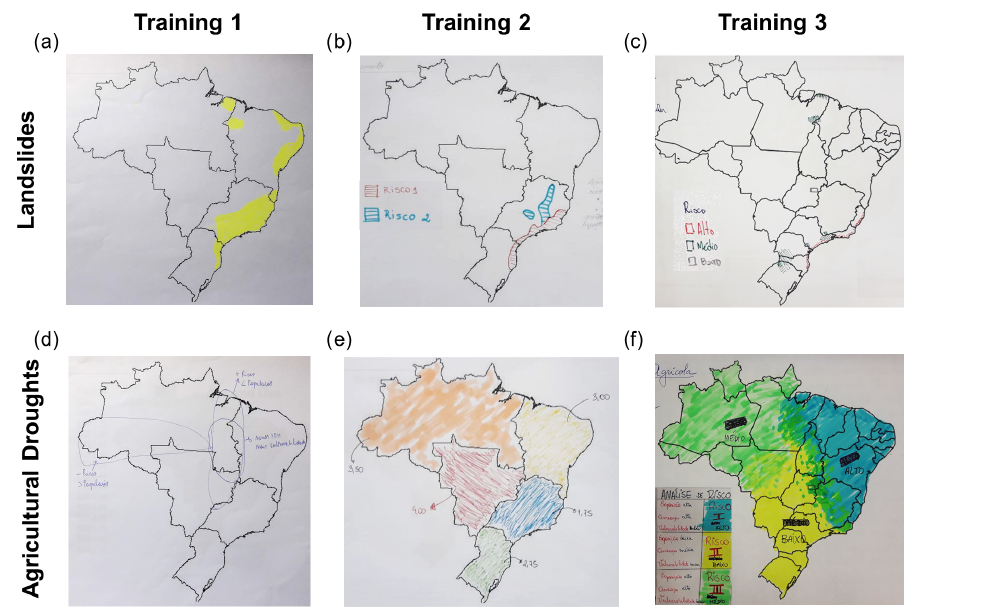
Figure 6. Outcomes from the climate risk mapping for landslides and agricultural droughts working groups (rows) from three trainings